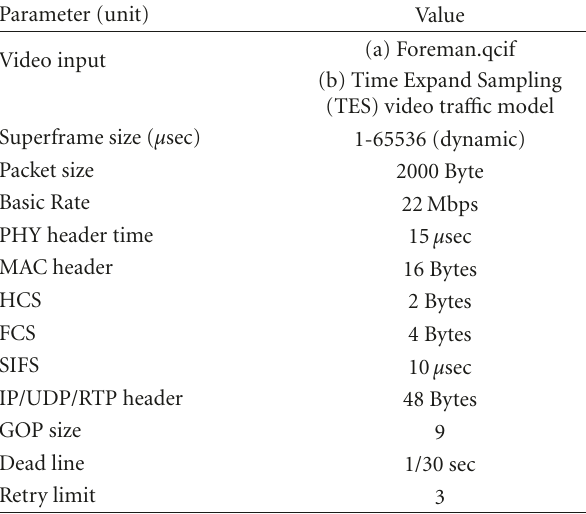
Table 1: Simulation Parameter.